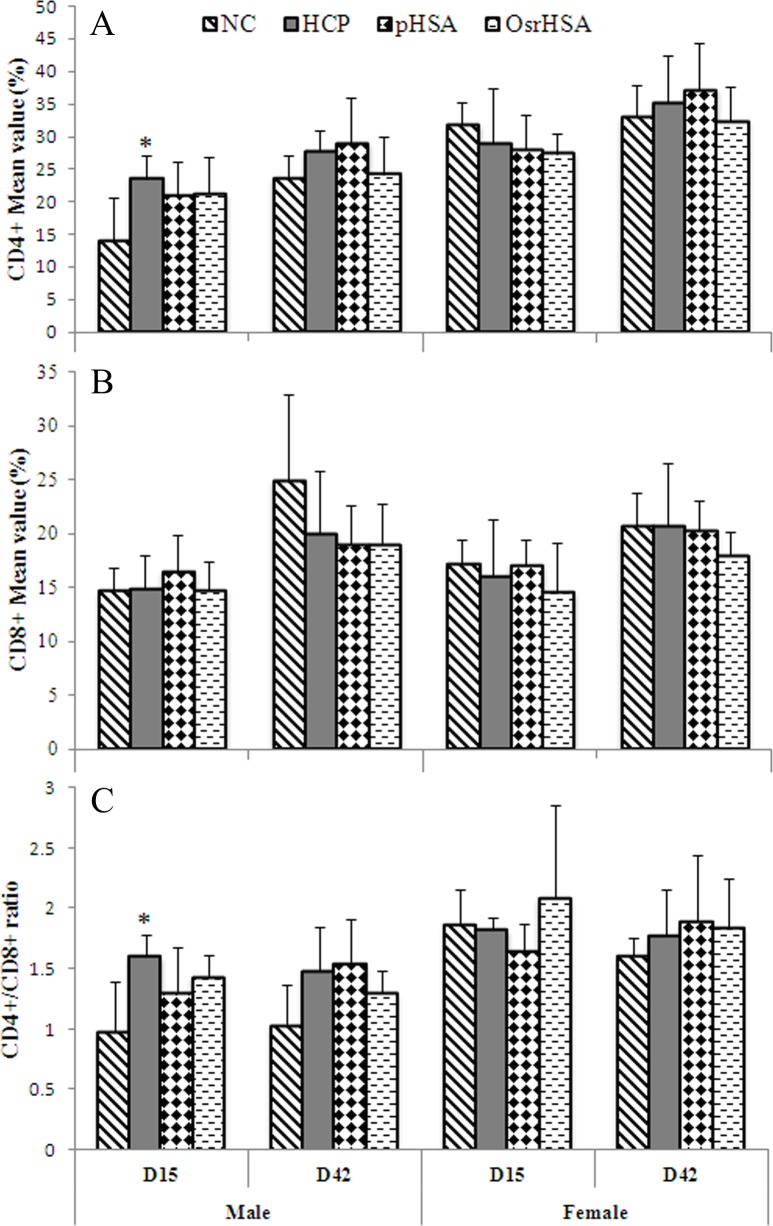
The changes in T-lymphocyte subsets at D15 and D42.Panel A shows CD4+ T cells, panel B shows CD8+ T cells, and panel C shows the ratio of CD4+/CD8+ T cells. The data are presented as the mean ± SD (n = 5). "*" Indicates a statistically significant difference according to ANOVA and Dunnett’s test (P≤0.05).